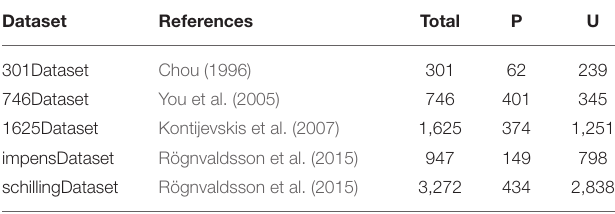
TABLE 1 | Detailed descriptions of five